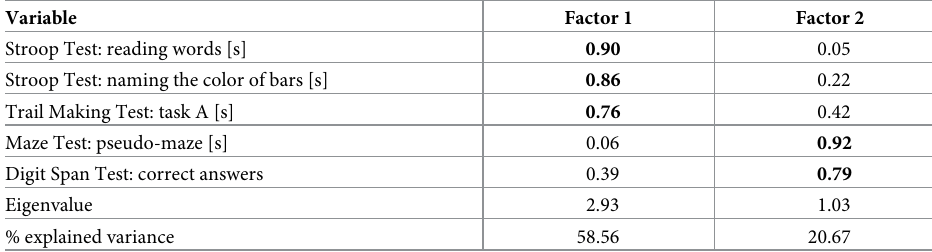
Applied was the principal component method with standardized varimax rotation. Illustrated are factors with eigenvalues larger than 1. Factor loadings larger than 0.7 are highlighted for